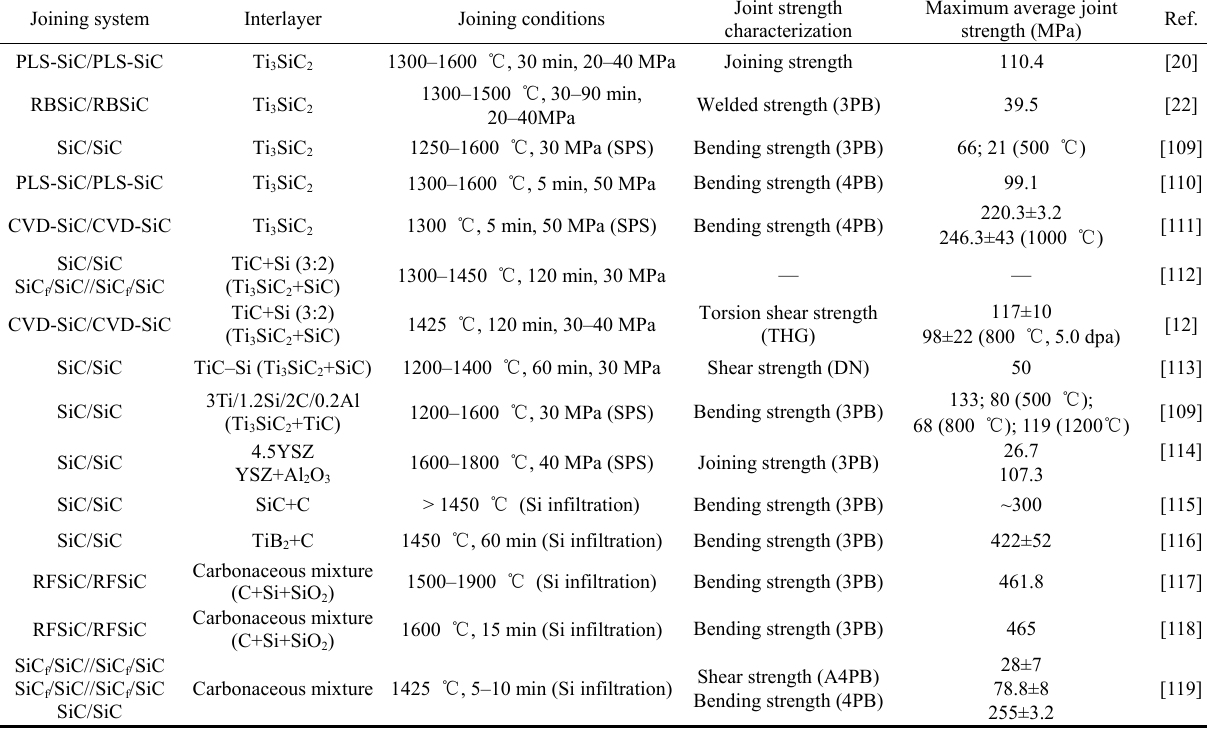
Table 8 Joining of SiC-based materials using ceramics as interlayer: interlayer, joining conditions, and joint strength Joining